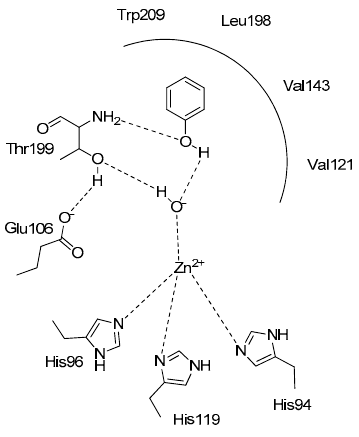
Figure 5. Schematic representation of the binding mode of phenol within the hCA II active site [48].